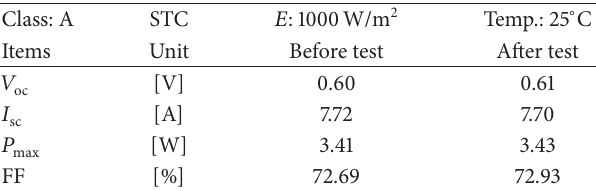
and 𝑇 ) glass , out glass , in and 𝑇 ) for the proposed PV air , out air , in